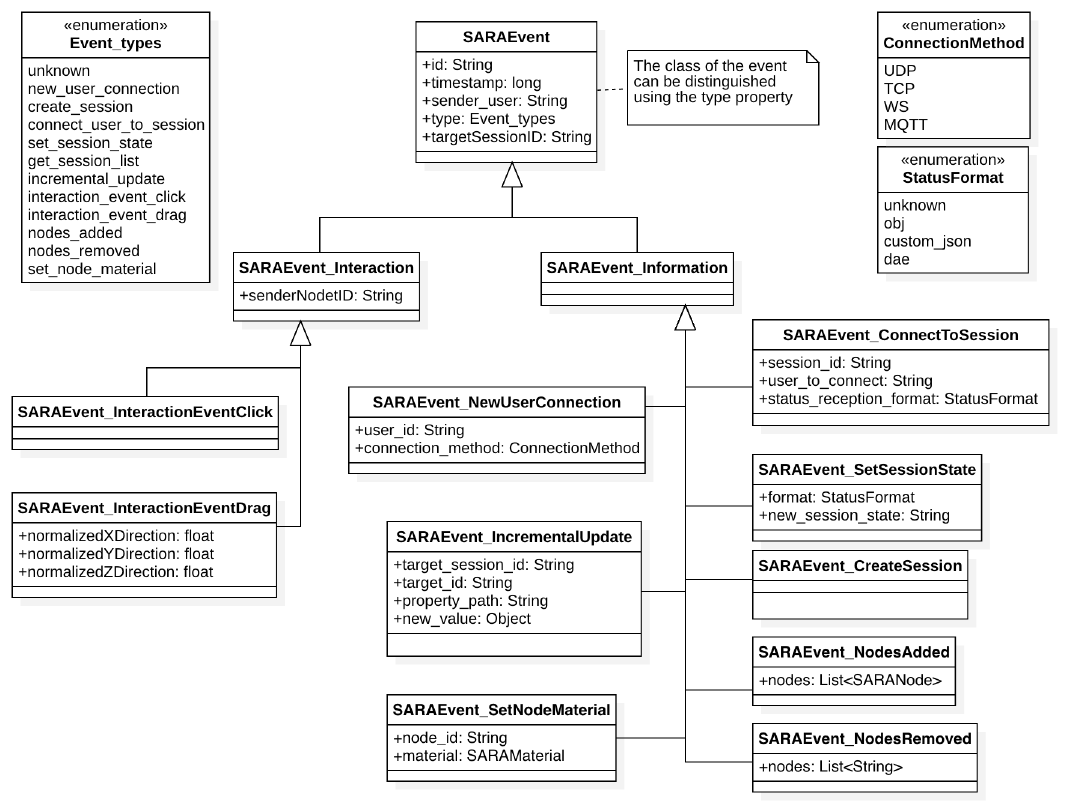
Figure 9. Data model of the Events handled by the